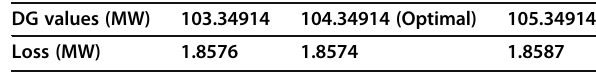
Table 15 Comparison of power loss at the IEEE 30 bus system with different DG power placed at bus no. 6 using JAYA algorithm